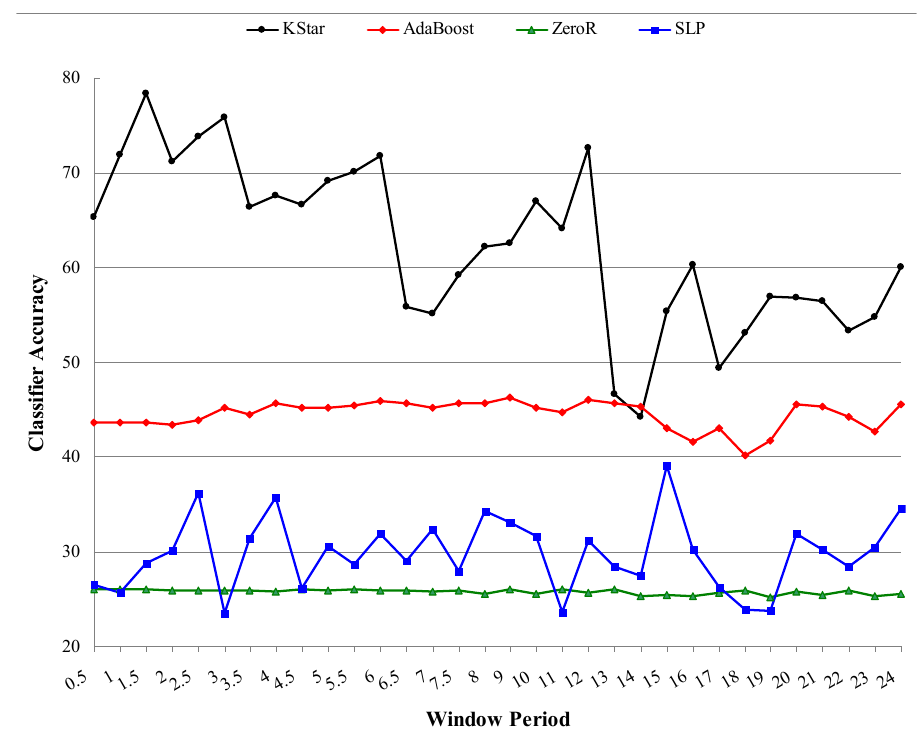
Figure 7. Classification accuracies of Kstar, AdaBoost, ZeroR, and SLP for different window sizes using the FNSW segmentation technique.